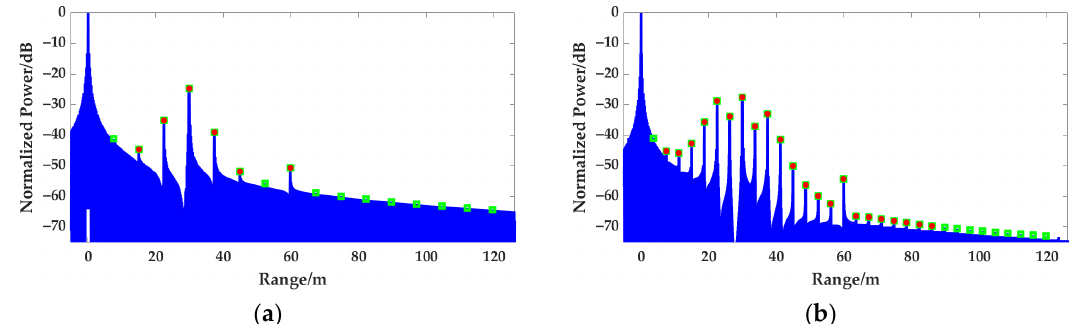
Figure 11. HRRPs with the stepped frequency of: ( a ) 20 MHz; ( b ) 40 MHz.